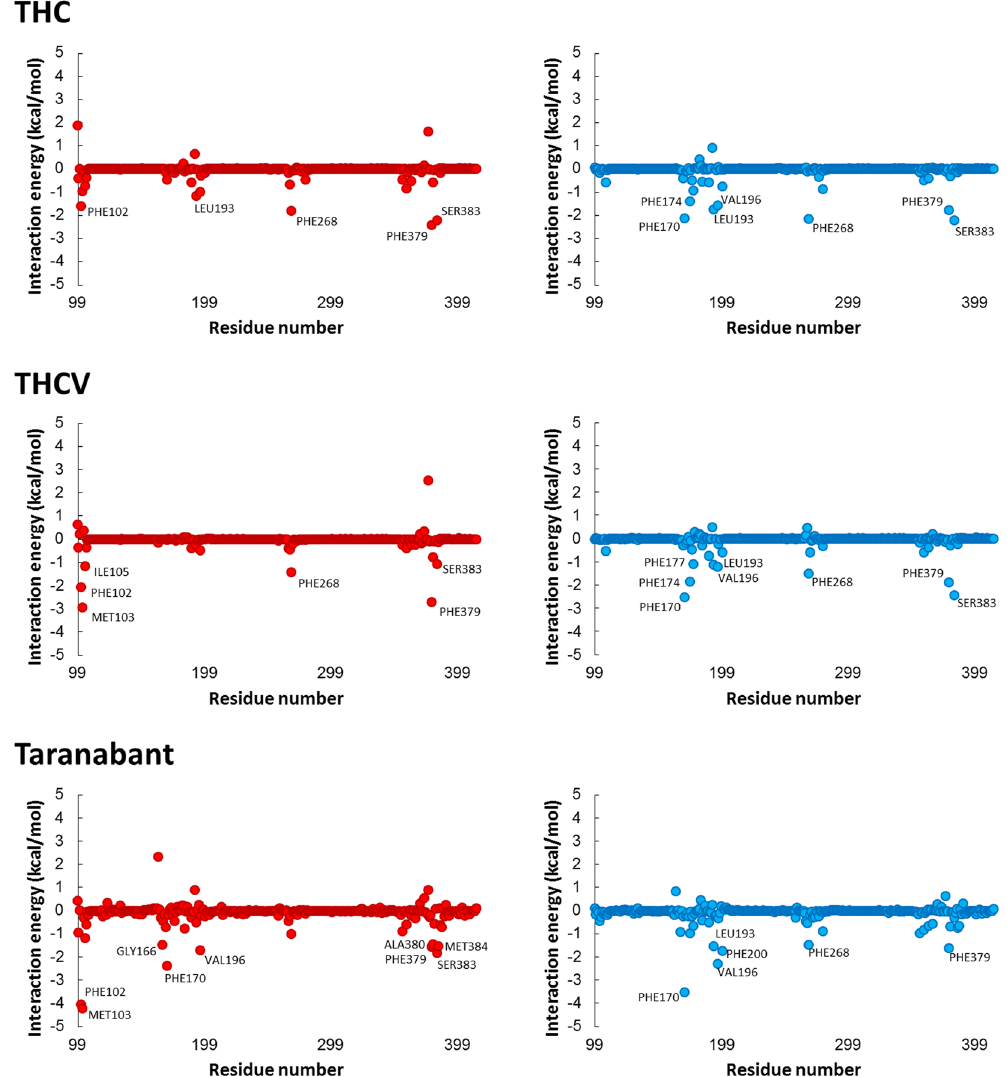
Figure 7. Per-residue binding free energy decomposition of inactive (left panel, red dots) and active (right panel, blue dots) CB1-ligand complexes. Residues with high energy contribution (the energy contribution ≤ − 1.0 kcal/mol) were